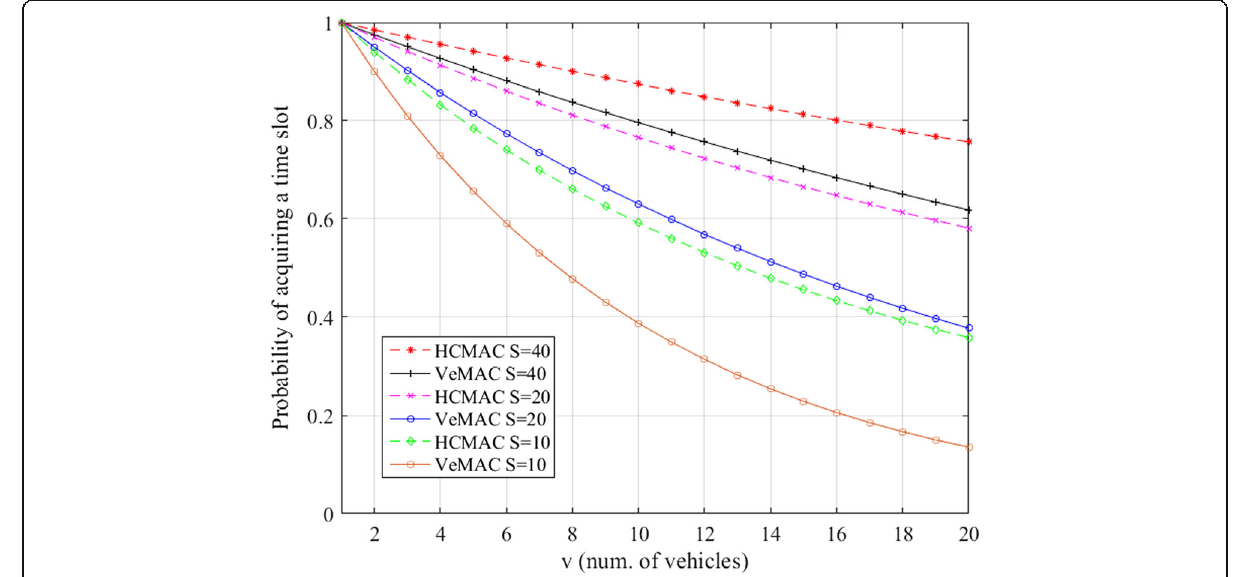
Fig. 10, HCMAC achieves a substantially higher prob- ability of acquiring a time slot compared to VeMAC.